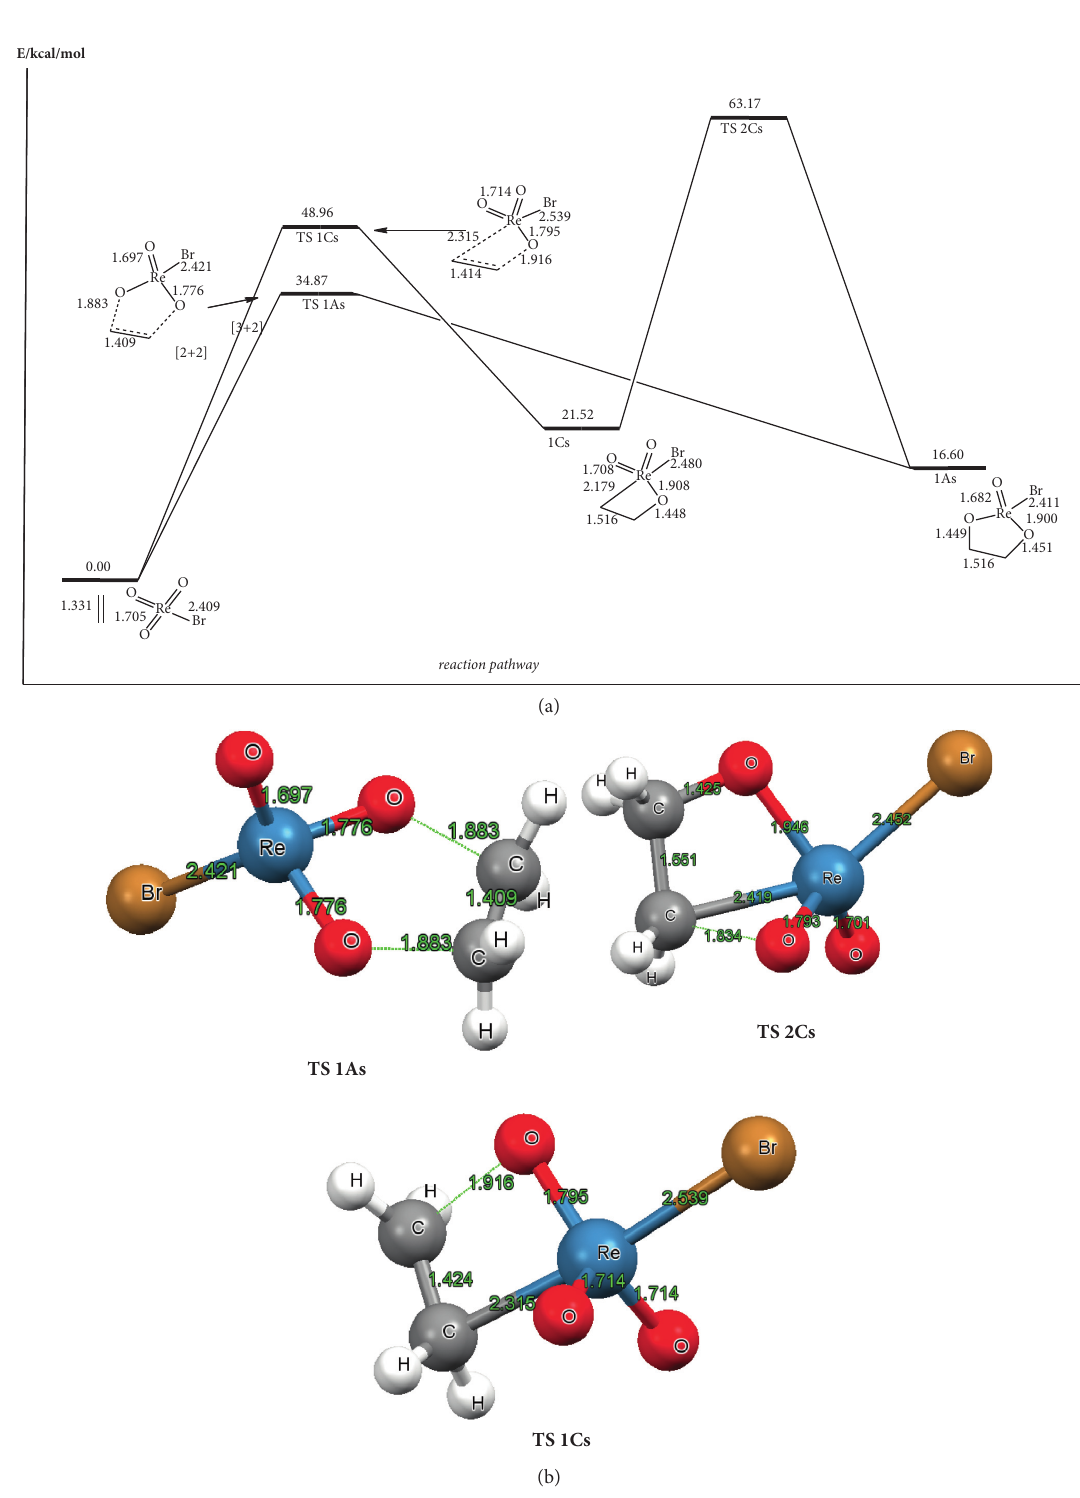
Figure 2: (a) Gibbs free-energy profile diagram for the reaction between ReO Optimized transition states involved in the reaction between ReO 3 Br and ethylene at the B3LYP/LACVP ∗ level of